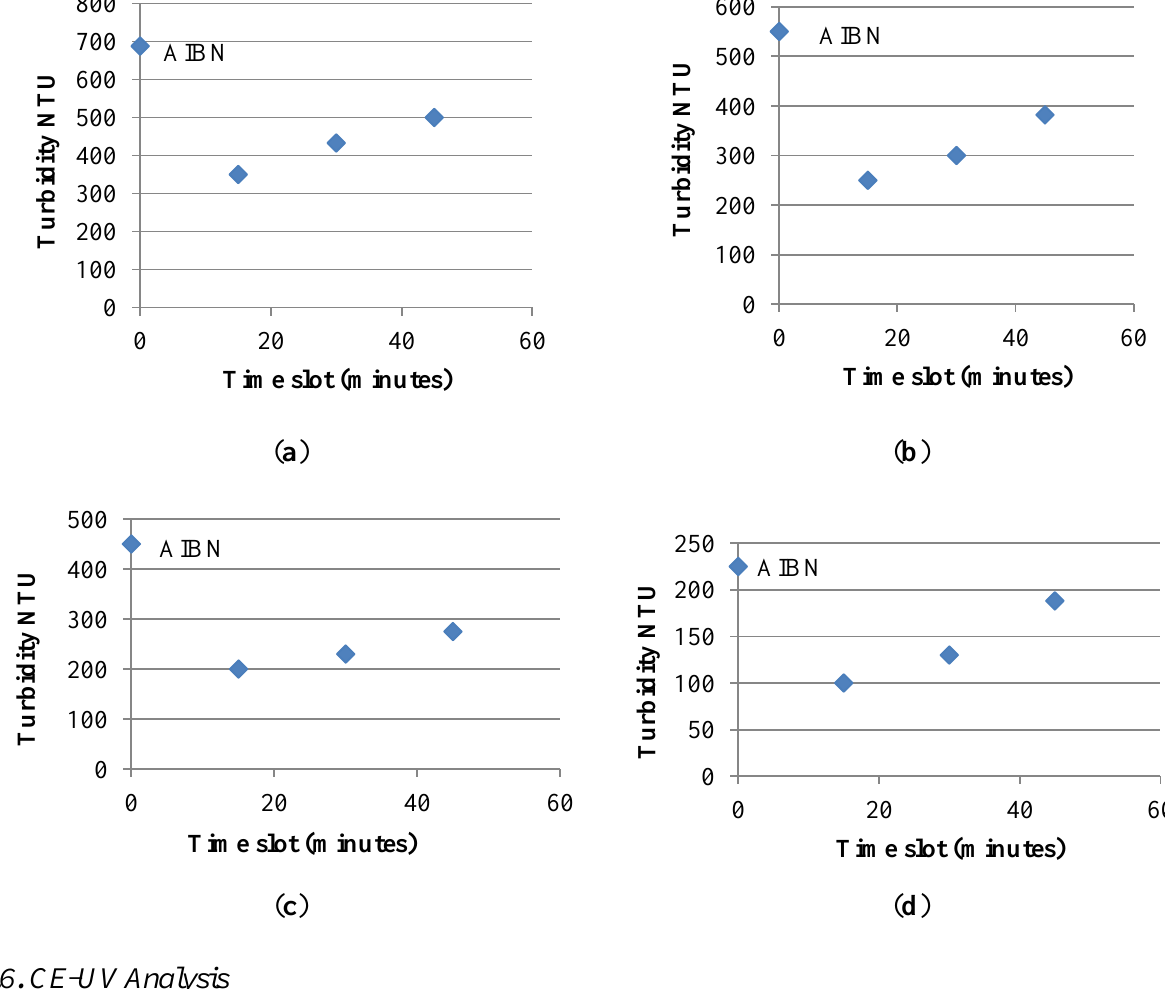
Figure 5. Turbidity values versus heating time at 60 °C for four samples containing 10 mg of AIBN, 1.5 mL of 30% silica and different volumes ( a ) 60 µL; ( b ) 50 µL; ( c ) 40 µL; ( d ) 30 µL of vinyl-2-pyrrolidone (VP) in a total volume of 2.0 mL. A reference value is included for 2,2'-azobis(2-isobutyronitrile) (AIBN) at 0